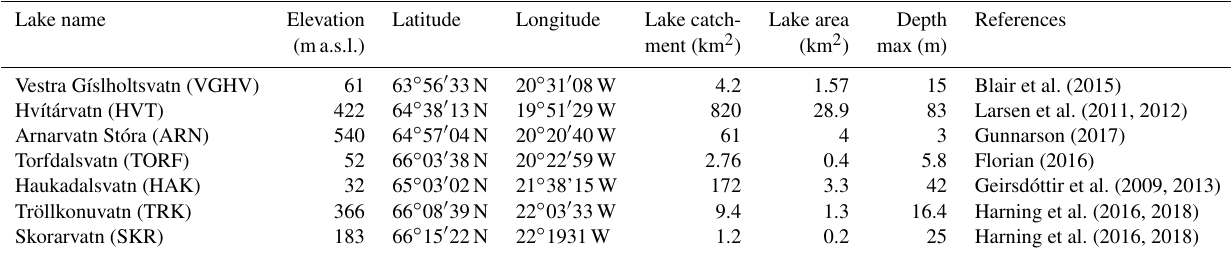
Figure 2. Air photographs of the seven lakes: (a) Tröllkonuvatn TRK, (b) Skorarvatn (SKR), (c) Torfdalsvatn TORF, (d) Haukadalsvatn HAK, (e) Vestra Gíslholtsvatn VGHV, (f) Arnarvatn Stóra ARN, (g) Hvítárvatn HVT. Air photographs (from 2005) are high resolution (0.5m) from Loftmyndir (http://www.loftmyndir.is/). Table 1. Lake